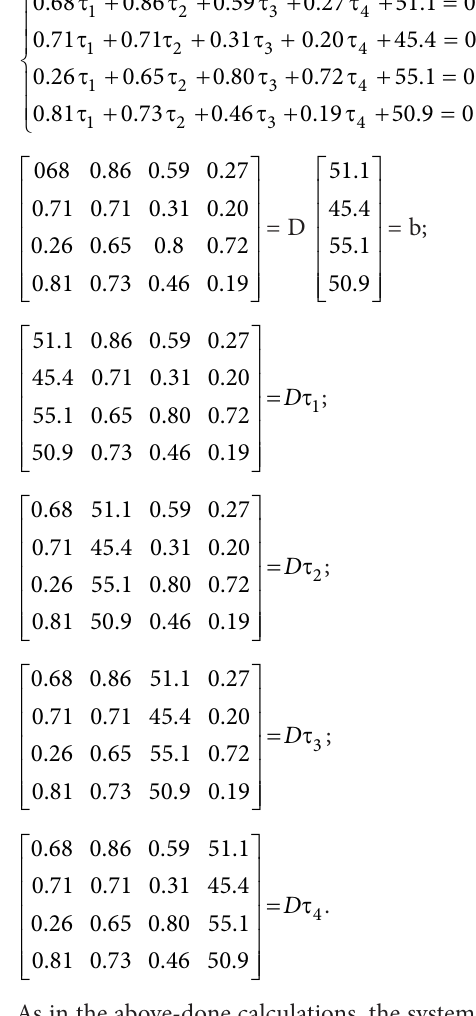
grain yielding capacity, c/hаMay 23 June